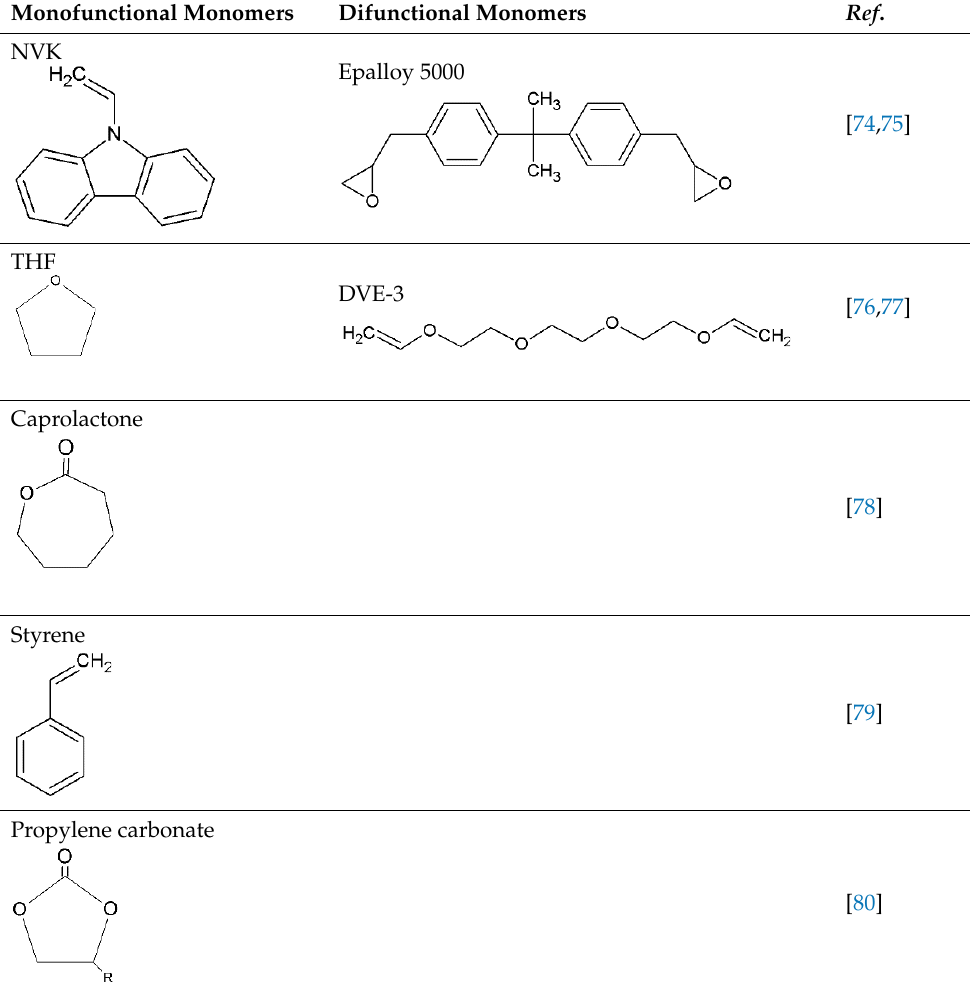
Table 1. Cont. Monofunctional Monomers Difunctional Monomers Ref